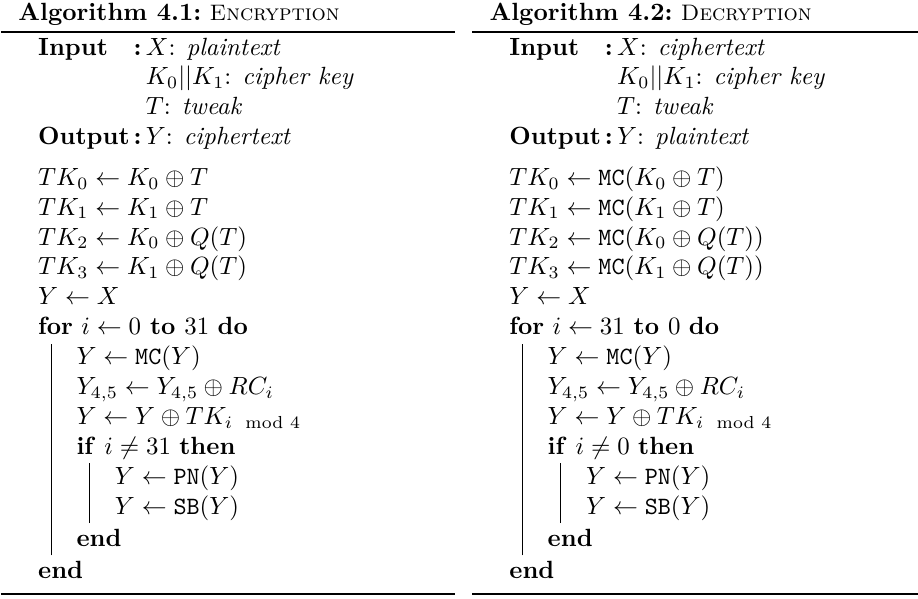
Algorithm 4.1: Encryption Algorithm 4.2: